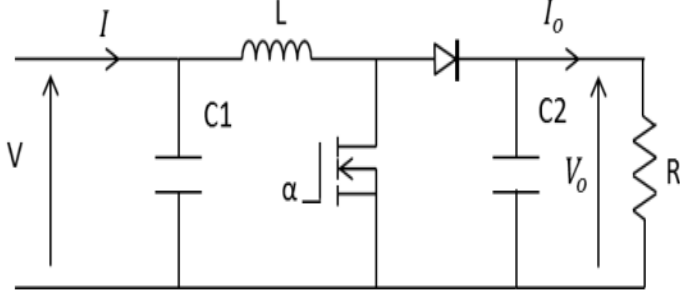
Figure 6. Boost converter scheme.